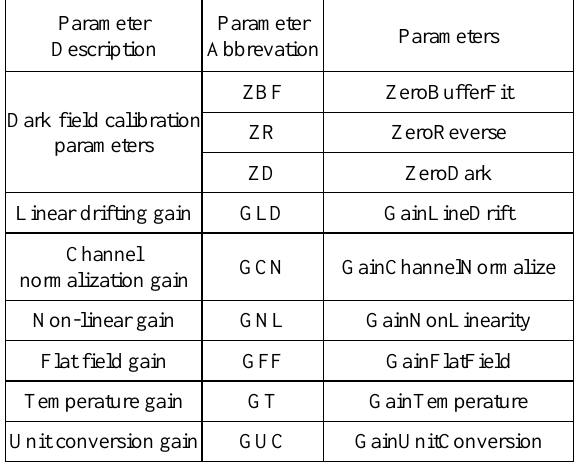
Table 1. Parameters of radiometric calibration for HiRISE As the original imagery data is compressed from 14 digits into 8 digits, the uncompressing processing shall be done before the radiometric calibration. For the convenience of calculation, we transfer the uncompressed data into 16 digits. Set the gray value of pixel of the original uncalibrated imagery as 𝑖𝐷𝑁 , the gray value after the calibration as 𝑜𝐷𝑁 , then the radiometric calibration formula of the HiRISE imagery is as below: